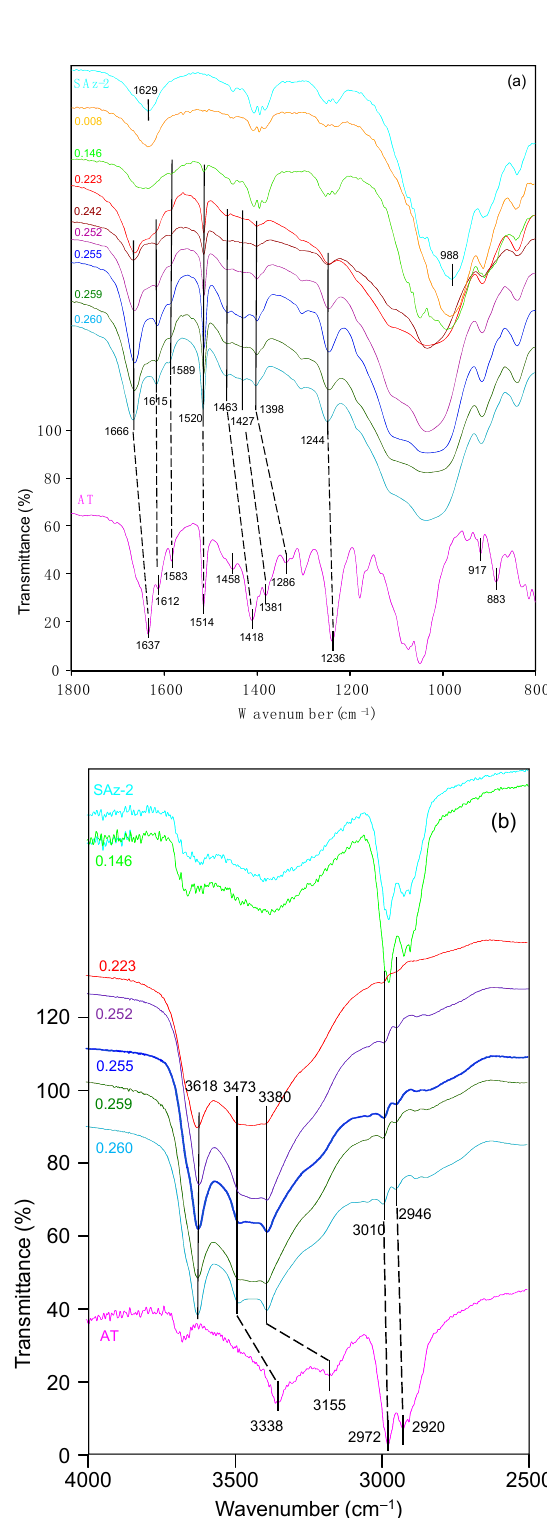
Figure 10. ( a ) FTIR spectra of raw SAz-2, solid AT, and SAz-2 with di ff erent amounts of AT adsorption. The values of left side are in CEC. The range is 800 − 1800 cm − 1 . (b) FTIR spectra of raw SAz-2, solid AT, and SAz-2 with di ff erent amounts of AT adsorption. The values of left side are in CEC. The range is 2500–4000 cm − 1 .